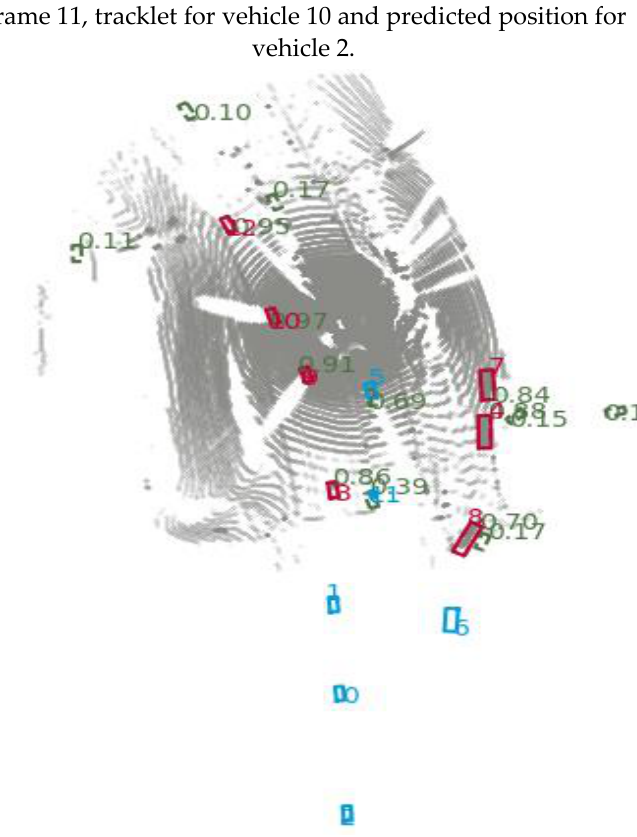
Frame 26, tracklet for vehicle 5,11 and predicted position for vehicle